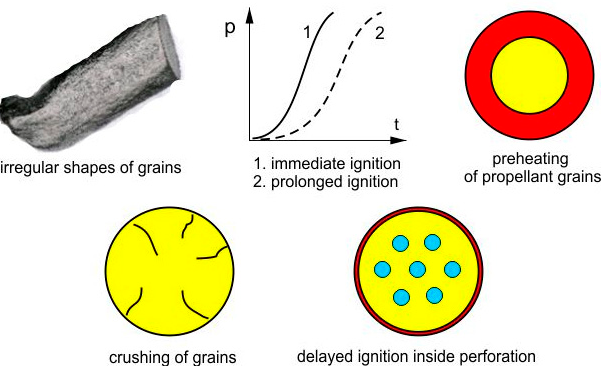
Figure 11. Illustration of factors that may affect determined values of coefficients θ and β .